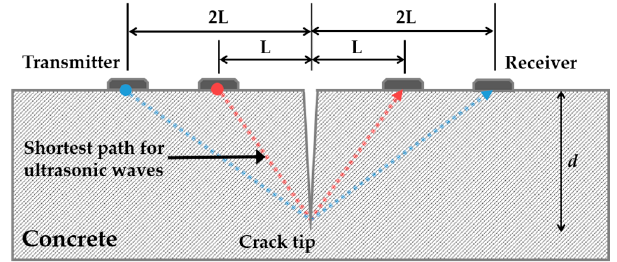
Figure 7. Concepts of time-of-flight diffraction (TOFD) methods.